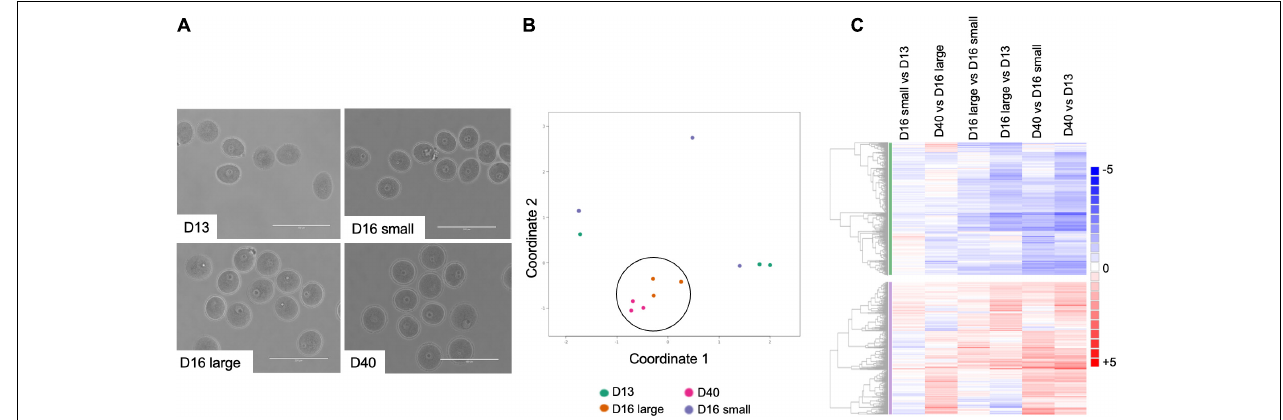
FIGURE 6 | Oocytes collected from mice across the pubertal transition have differential patterns of gene expression. (A) Representative transmitted light images of oocytes used for RNASeq analysis from mice at different ages: PND 13, PND 16 small (from small mice), PND 16 large (from large mice), and PND 40. (B) Multidimensional scaling (MDS) plot shows oocytes from PND 16 large and PND 40 clustered together (circle) as compared to PND 13 and PND 16 small oocytes. (C) Pairwise analysis of differentially expressed genes (fold change + 1.5 and − 1.5 and adj p < 0.05) across different oocyte cohorts shows similar gene expression patterns when comparing PND 16 large with PND 13, PND 40 with PND 16 small and PND 40 with PND 13.